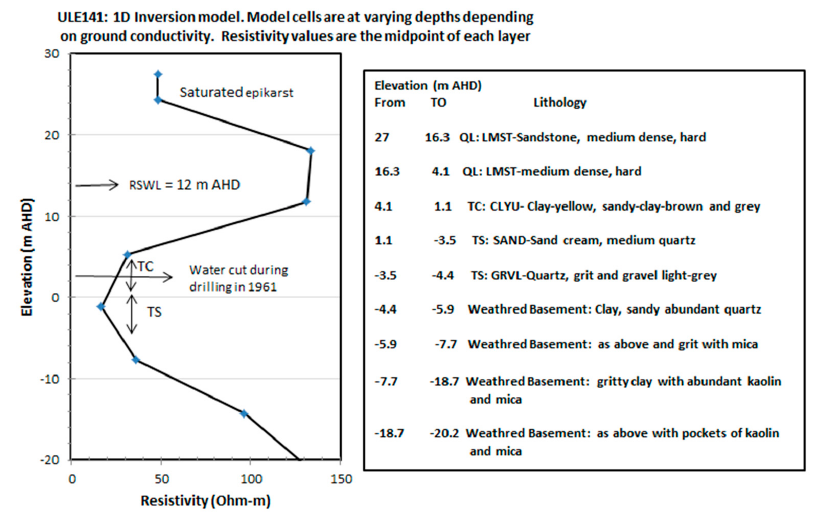
Figure 9. Resistivity profile at ULE141 site (station 1000 on LO2-A) with lithology.